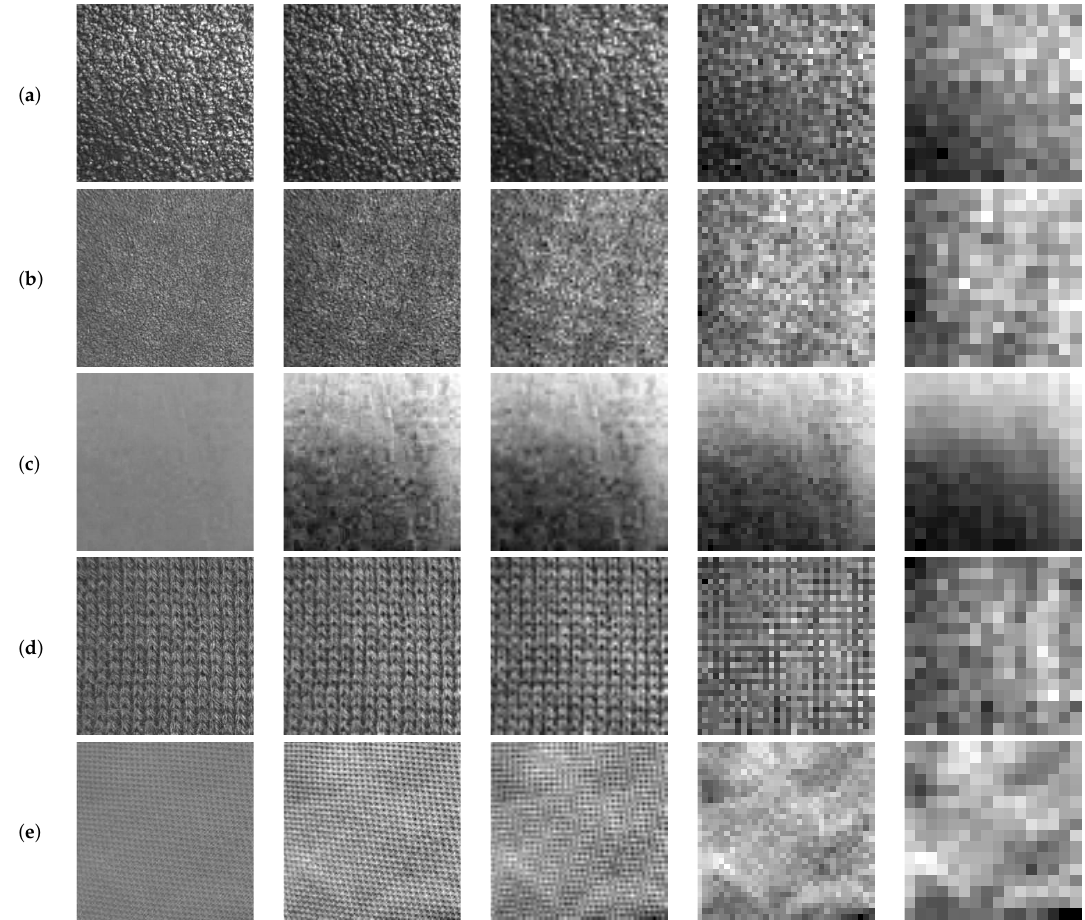
( j ) Figure 8. Approximation subimages ( f ) of four wavelet decomposition levels for different textures. LL ( a ) Sandpaper (course appearance); ( b ) sandpaper (fine appearance) and ( c ) painted-surface: statistical textures; ( d ) fabric (course appearance) and ( e ) fabric (fine appearance): structural